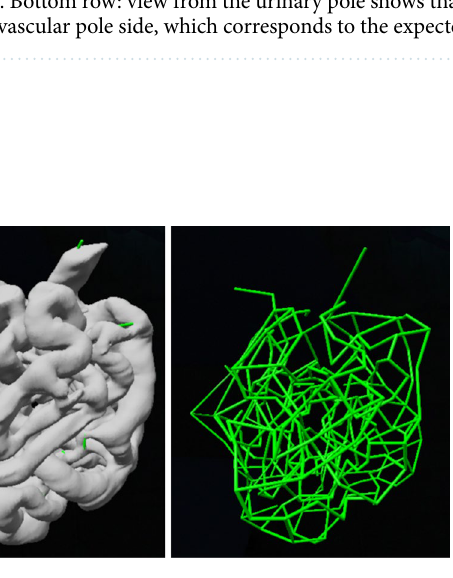
Figure 4. Three dimensional network diagram constructed from a glomerular reconstruction. The nodes and connections were identified and constructed in a 3D virtual reality